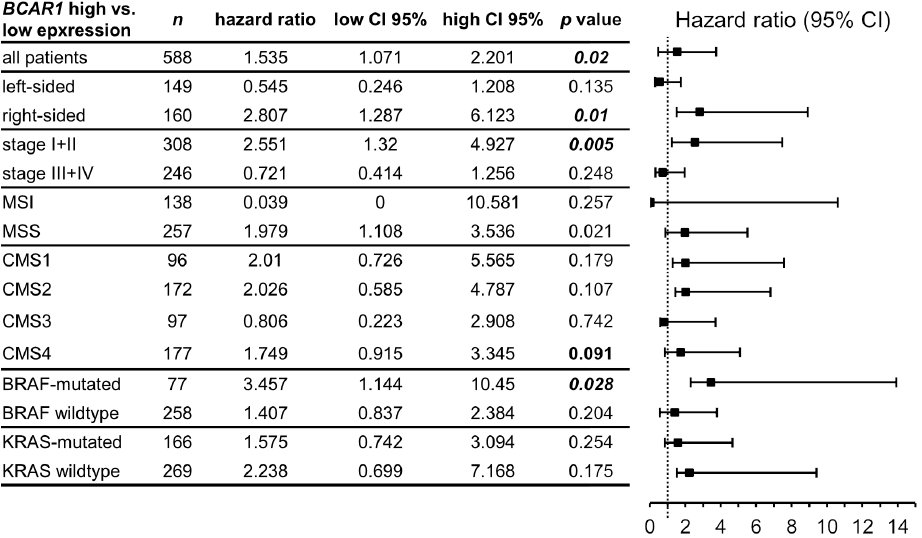
Figure 6. BCAR1 expression is associated with poor outcomes in right-sided, stage I and II, MSS, or BRAF -mutated CRCs. Overall survival was analyzed in the indicated subgroups (TCGA CoAd data set) as described in Materials and Methods. CI, confidence interval.